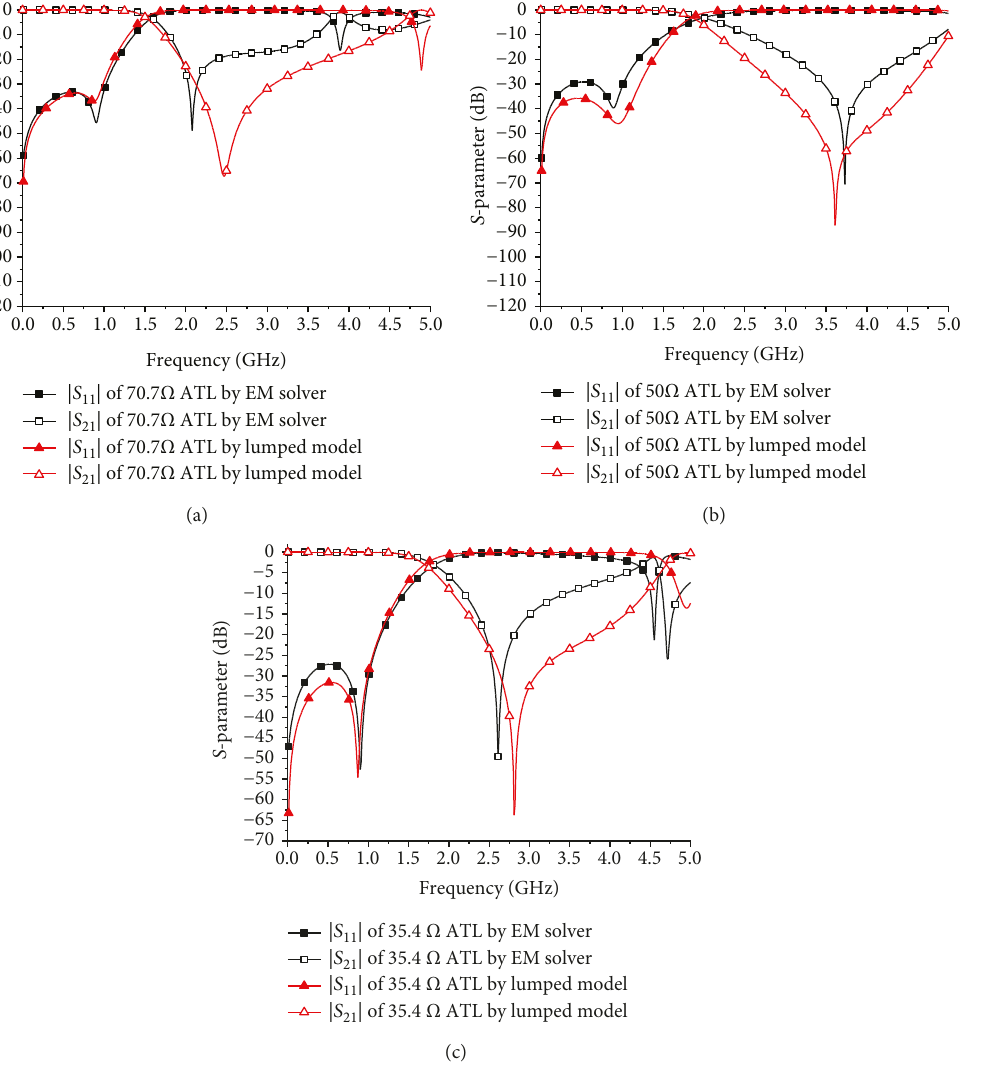
Figure 6: Simulated S -parameter of the proposed ATLs: (a) 70.7 Ω , (b) 50 Ω , and (c) 35.4 Ω